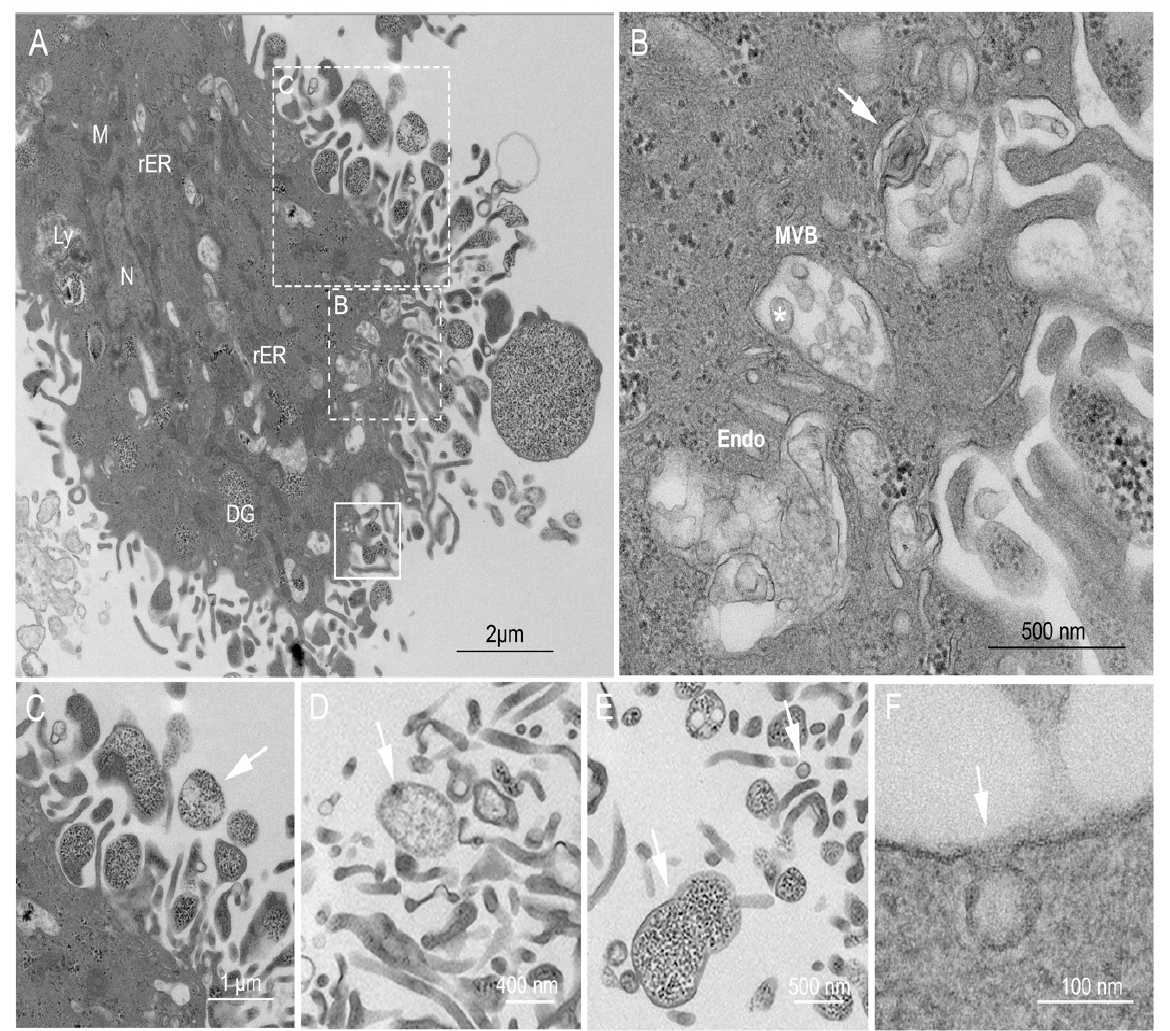
Figure 2. Transmission electron microscopy (TEM) characterization of USCs, and extracellular vesicles EVs morphology and Biogenesis; ( A ) USCs TEM where different cell structures can be visualized such as the nucleus (N), abundant mitochondria (M), rough endoplasmic reticulum (rER), lysosomes (ly), pools of dense granules (DG) and multivesicular body (MVB); magnified in ( B ), where biogenesis of exosomes can be observed in the three phases described, endosomes (Endo), MVB containing intraluminal vesicles of different sizes (Asterix) and fusing of MVB to the membrane with exosome release (Mic. Mag. ×13,000). The cell membrane exhibits multiple projections, membrane budding forming vesicles (solid square) and micro–vesicles (large dotted square, illustrated in ( C ) containing dense granules varying in size, shape, and content, (Mic. Mag. ×2900). ( C – E ) The pictures show the heterogenicity in sizes and density, varying dense granules containing larger vesicles between 150 nm–1 μ m, typical for micro–vesicles ( C – E ), and homogenous less granular vesicles < 150 nm, typical for exosomes ( E , F ), (Mic. Mag. ×2900). ( F ) Vesicle enclosed by USC membrane, mimic endocytosis (Mic. Mag. ×18,500) (Lead citrate/Uranyl acetate stain).